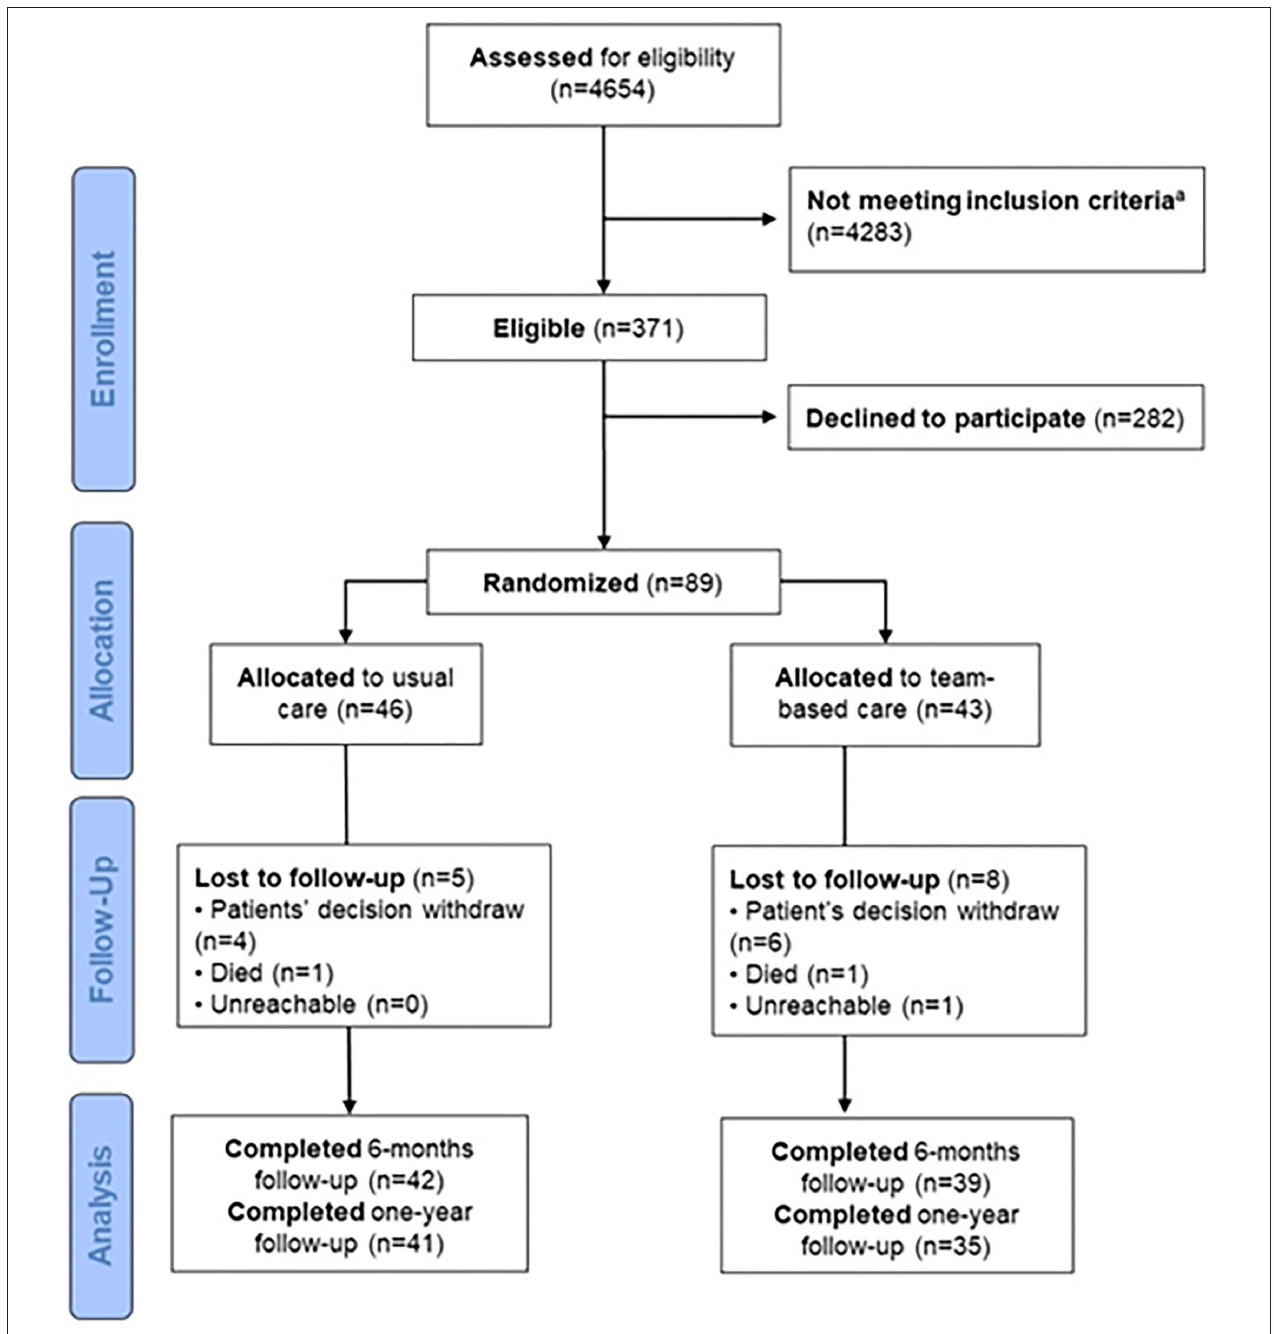
FIGURE 1 | Flow diagram of included patients. a Of the 4,283 who did not meet inclusion criteria, 195 have HTN drug treatment since < 1 months, 1,388 did not have HTN drug treatment, 1,063 did not have recent BP measurement, 315 were aged < 18 years, 486 were hospitalized or nursing home and 320 were patients not followed by participating